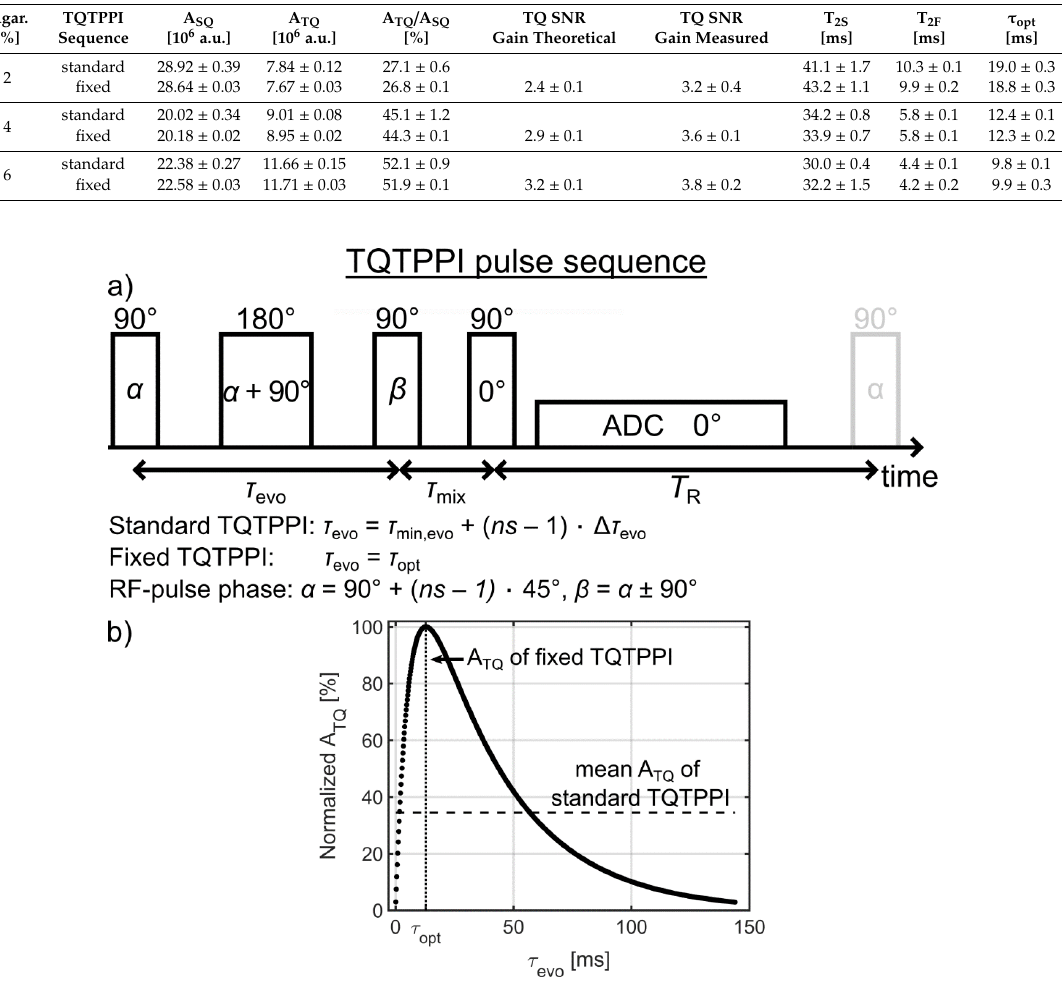
Table 1. Comparison of standard and fixed TQTPPI FID fit results. The values of A SQ and A TQ from the standard TQTPPI pulse sequence were corrected to the optimal evolution time, which was set for the fixed TQTPPI pulse sequence, by using Equation (1). The transverse relaxation times of the fixed TQTPPI pulse sequence were determined by a variation of the evolution time followed by a simultaneously fit of A SQ and A TQ using Equations (4) and (5), respectively.